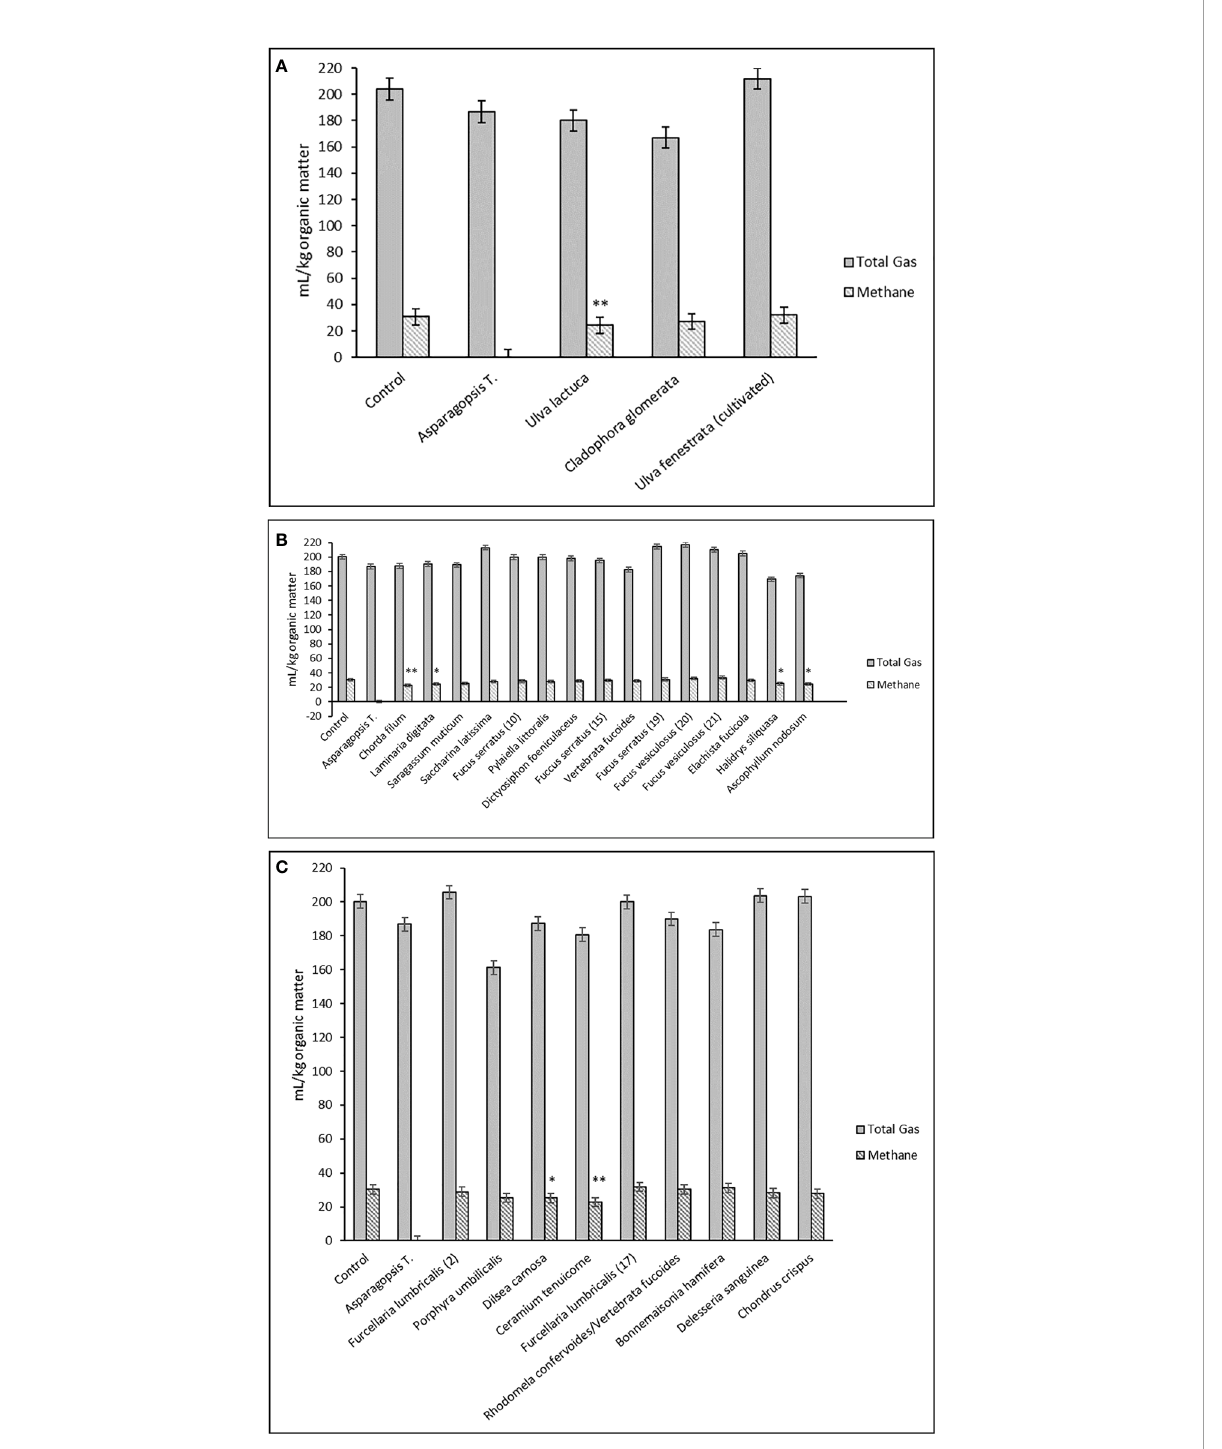
FIGURE 1 (A – C) : Total gas and in vivo predicted CH 4 production (mL/kg organic matter (OM)) for the three main phyla Chlorophyta (green; a), Phaeophyceae (brown; b) and Rhodophyta (red; c) of experimental seaweeds added to grass silage. The standard errors of the least squares means were 14.1 for total gas and 1.76 mL/kg of OM for CH 4 . Asterisks indicate least signi fi cant difference of seaweed treatment compared to control sample of grass silage (CH 4 ): ** P < 0.01 and * P < 0.05. There were no differences between control samples and treatments in terms of total gas ( P > 0.05) and no CH 4 was produced with Asparagopsis taxiformis , which was signi fi cantly different from all other treatments ( P < 0.01) (results not indicated with